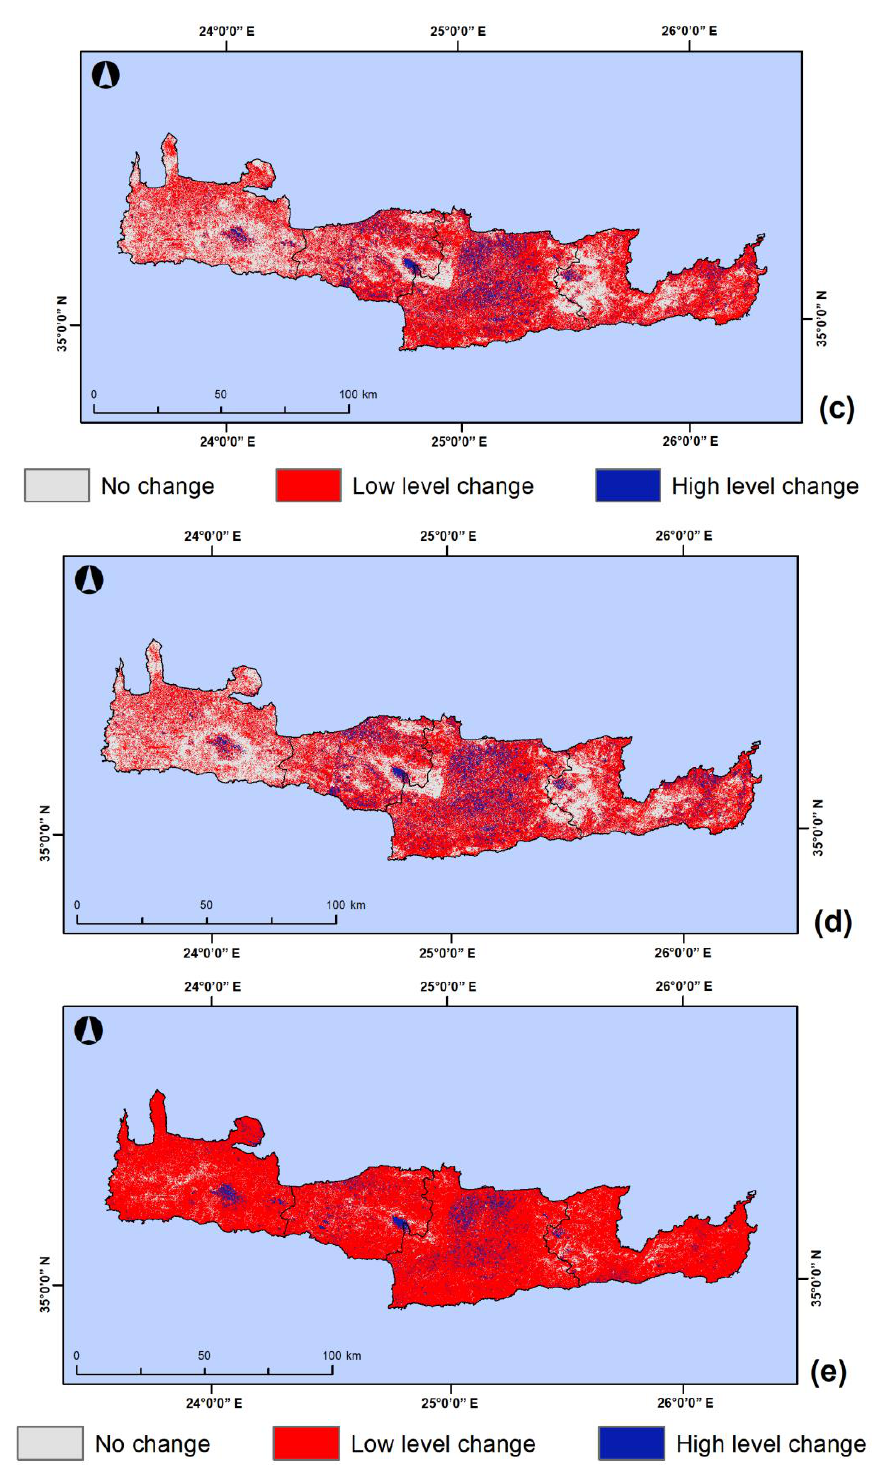
Figure 6. Change magnitude maps for the period of 2009–2019 from different index combinations: ( a ) NDVI–albedo; ( b ) NDVI–BSI; ( c ) SAVI–albedo; ( d ) SAVI–BSI; ( e ) TCG–TCB.